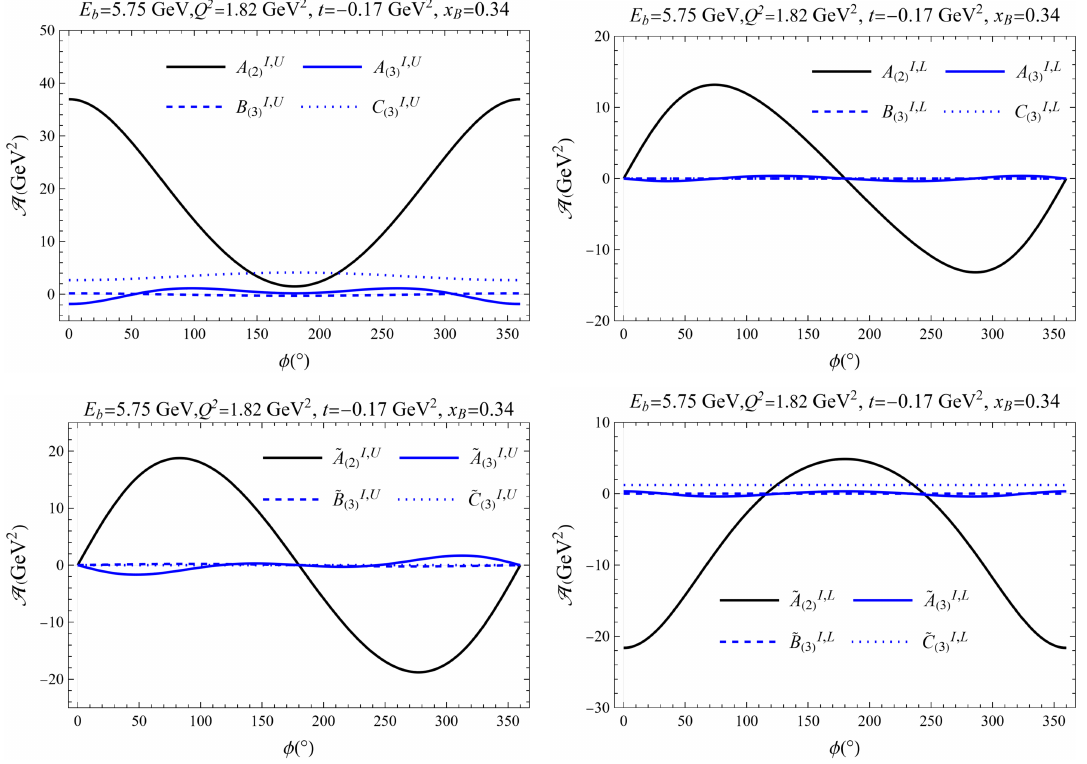
with A = { A, B, C, e A, e B, e C } for JLab (3) and e A I , U / L as the (2) (2)